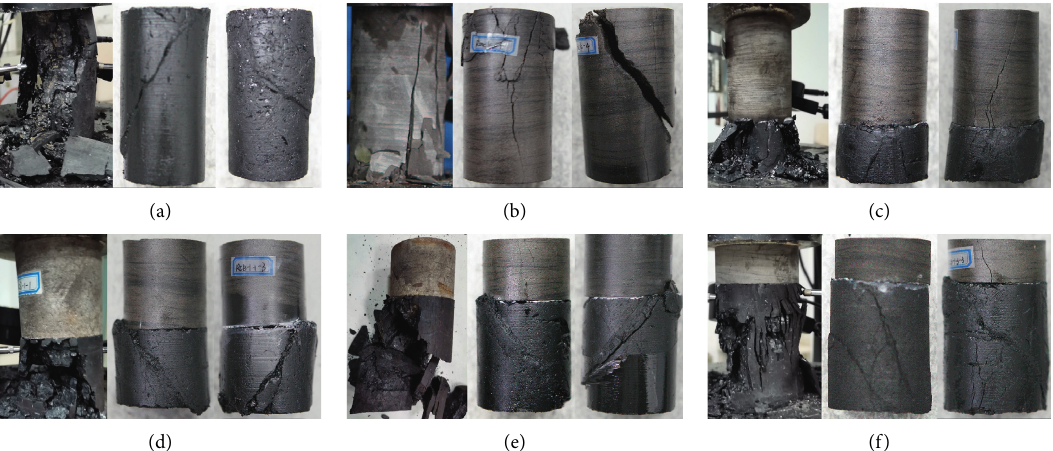
Figure 11: Failure patterns of coal-rock combination and the coal and rock samples under different confining pressures; from left to right, the confining pressures are 0MPa, 5MPa, and 10MPa for each group of pictures. (a) Coal. (b) Rock. (c) RCB-2-1. (d) RCB-1-1. (e) RCB-1-2. (f)